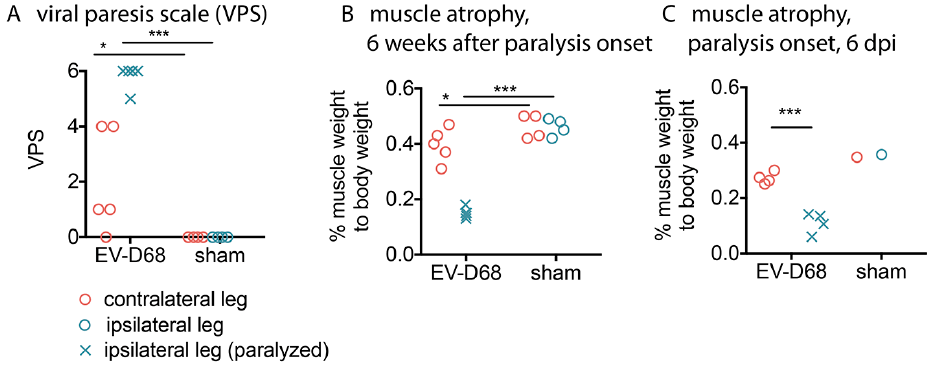
Figure 1. Hindlimb motor deficits and muscle atrophy in AG129 mice at onset of paralysis or 6 weeks after onset of viral paralysis. ( A ) Viral paresis scale (VPS). Weights of gastrocnemius and soleus muscles as a percentage of whole body weight were used to evaluate muscle atrophy measured at the time of necropsy at ( B ) 6 weeks after paralysis; and ( C ) at onset of paralysis. * p < 0.05, *** p < 0.001 as compared to respective leg controls using one-way analysis of variance.